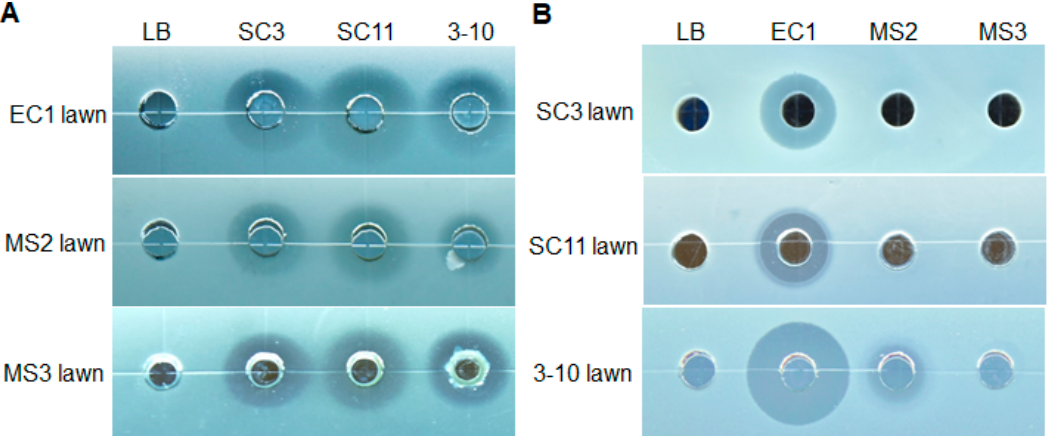
Figure 1. Inhibitory activities of antagonistic strains and Dickeya zeae pathogens in spot-on-lawn assay. The plates were incubated at 28 °C for 24 h. ( A ) the antagonistic activities of strains SC3, SC11 and 3-10 against pathogenic D. zeae strains EC1, MS2 and MS3; ( B ) inhibitory activities of D. zeae pathogens against antagonistic strains SC3, SC11 and 3-10.